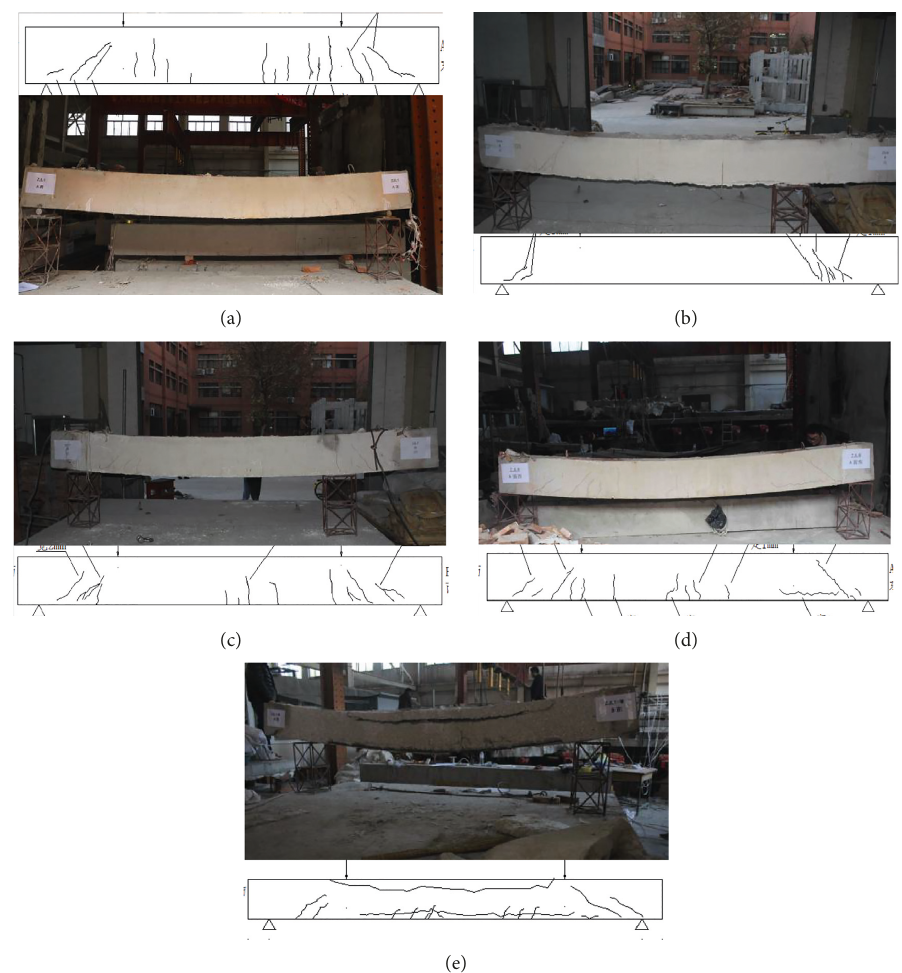
Figure 8: The failure modes of RC beams (dimensions in mm): (a) B2, (b) B3, (c) B4, (d) B5, and (e)